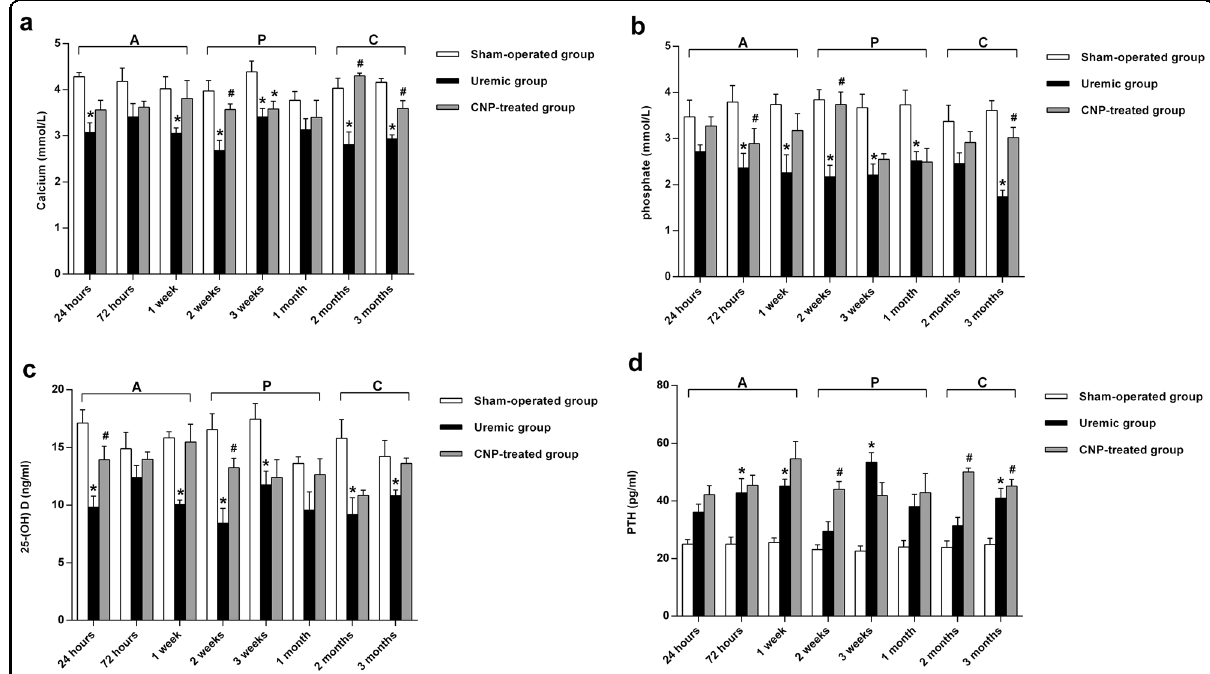
Fig. 3 Serum calcium, phosphate, 25-(OH) D, and PTH in sham-operated, uremic, and CNP-treated rats. Uremic group vs. sham-operated group : The levels of calcium, phosphate, and 25-(OH) D gradually decreased during our observational period and moreover, were signi fi cantly lower than those in the sham-operated group in every stage ( a – c ); serum PTH was signi fi cantly higher in the uremic group than in the sham-operated group from the acute stage to the chronic stage ( d ). CNP-treated group vs. uremic group: CNP administration could signi fi cantly enhance calcium and PTH levels in the progressive stage and chronic stage ( a , d ); 25-(OH) D in the acute stage and progressive stage ( c ); and phosphate throughout our observational period ( b ). CNP-treated group vs. sham-operated group: CNP recovered the levels of calcium, phosphate, and 25-(OH) D to those in the corresponding sham-operated group in the chronic stage ( a – c ); PTH signi fi cantly increased in the CNP-treated group throughout the whole observational period ( d ). * P < 0.05, signi fi cantly different from the corresponding sham-operated group; # P < 0.05, signi fi cantly different from the corresponding uremic group. A acute stage, P progressive stage, and C chronic